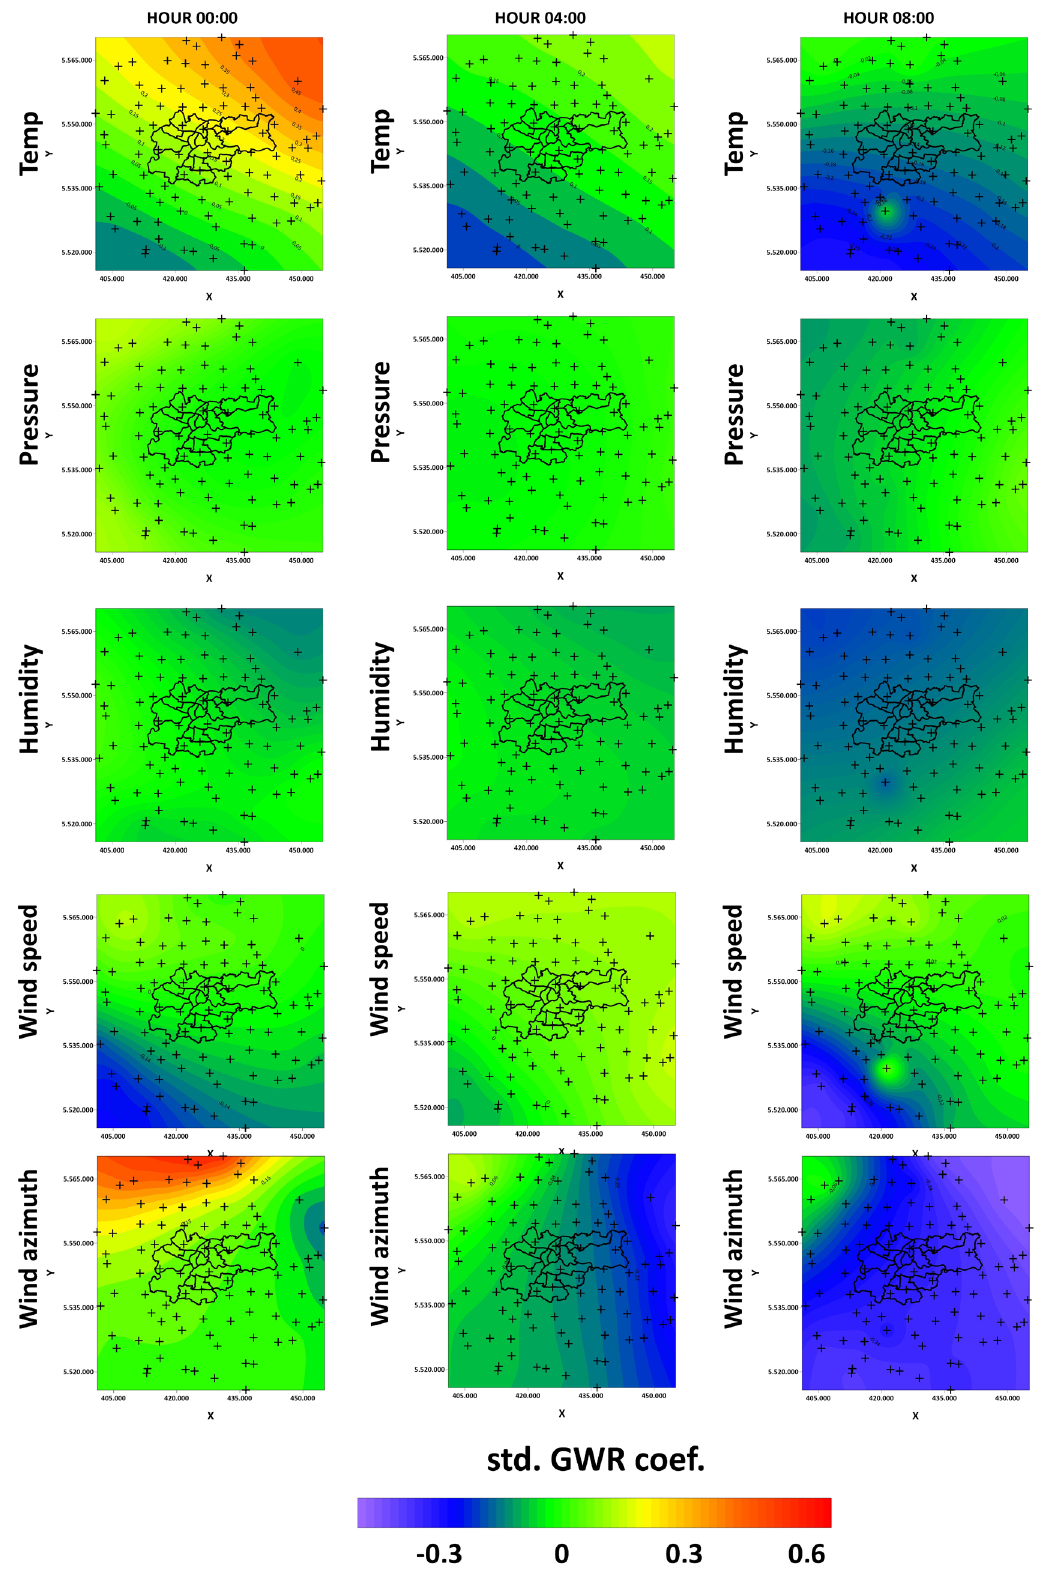
Figure 10. GWR coefficients for different meteorological factors on the 11th of March